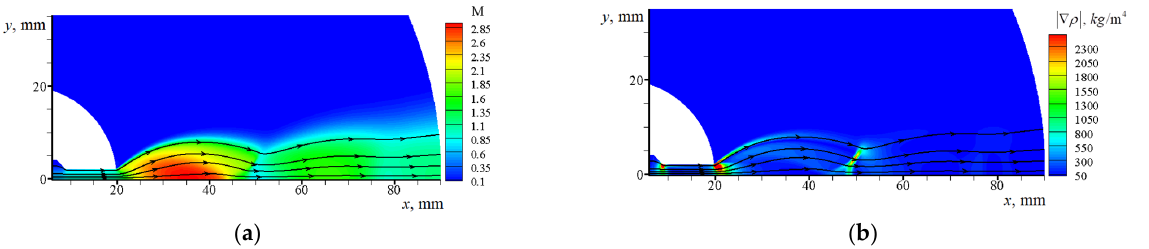
Figure 19. Calculated data for a two-phase jet without particles exhausting from a channel into a slotted space with h = 0.8 mm: ( a )—Mach-number isolines M ( x , y ) and gas-flow streamlines; ( b )—isolines of density gradient |∇ ρ | .